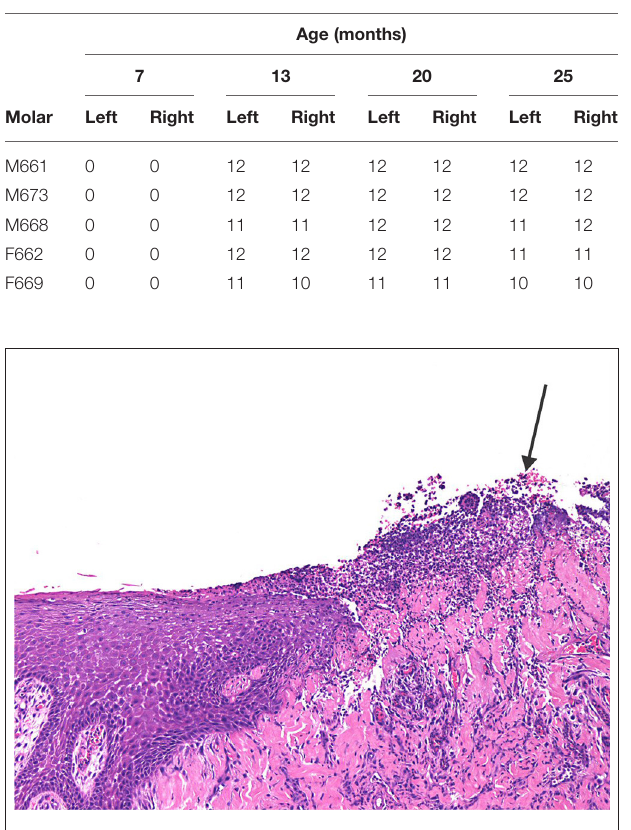
TABLE 5 | The molar height (mm) of five young growing cheetahs from the Ann van Dyk Cheetah Centre (from 13 to 25 months-of-age) after eruption (0mm at 7 months indicate these teeth were not erupted).